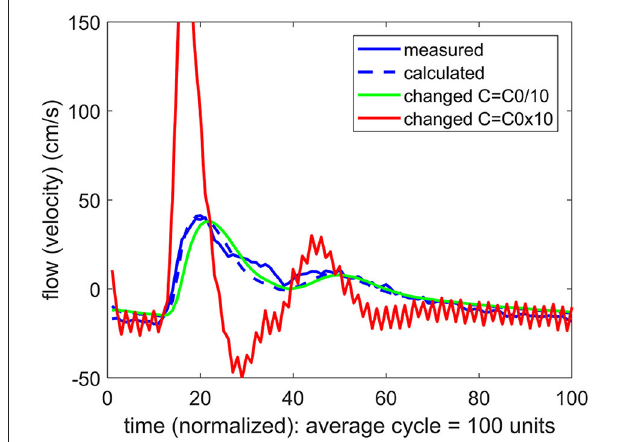
FIGURE 6 | A test of the role of compliance “ C ” in the relationship between pulsatile pressure and flow (velocity), as in Figure 5 , but here applied to pulsatile blood flow within the cerebral vascular bed. The actual compliance “ C 0 ” of the vascular bed is here again determined by agreement between the measured and predicted flow waveform. When this value of C is changed, however, the result depends on whether the change is to higher or to lower values. At lower values of C there is little effect, indicating that compliance is not playing a significant role in the relationship between pulsatile pressure and flow.